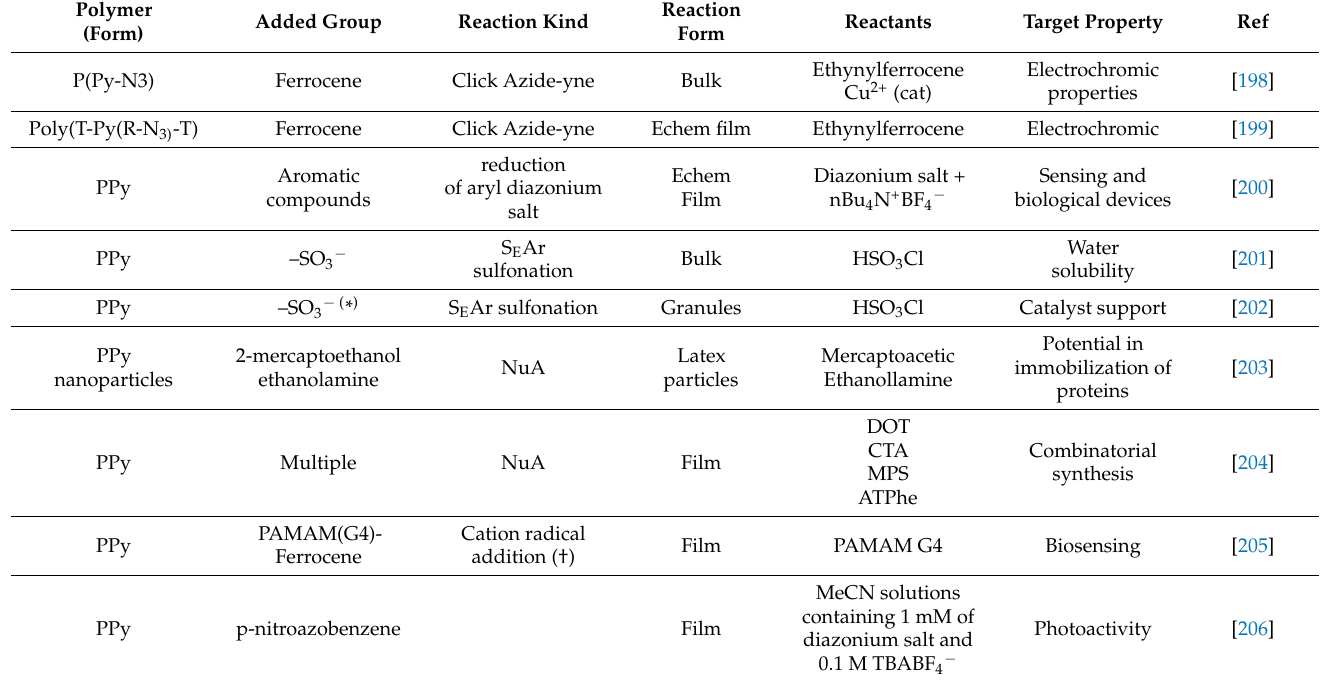
Table 3. Summary of reaction used in polypyrrole